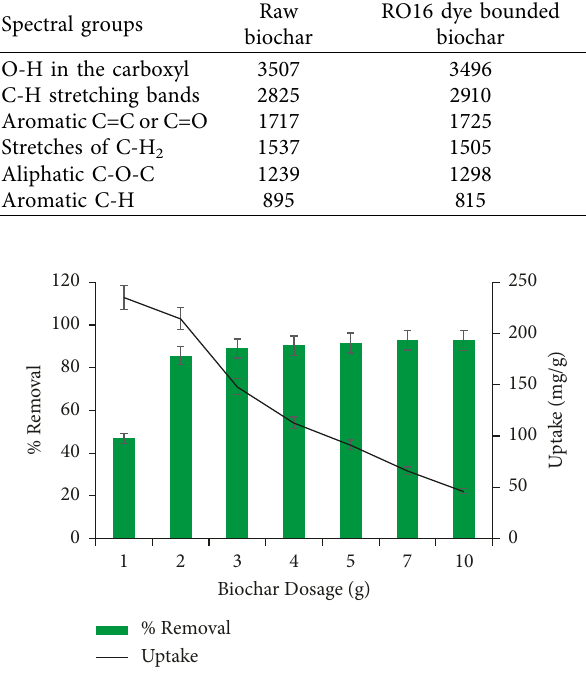
Figure 1: The effect of biochar concentration on RO16.